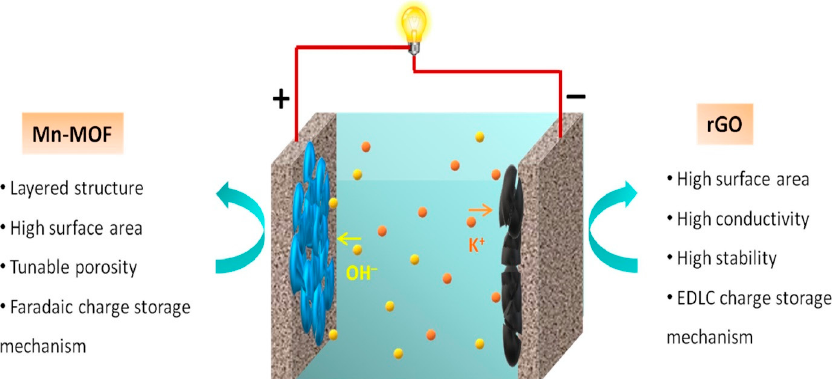
Figure 6. Schematic illustration of hybrid supercapacitor with Mn-MOF as a positive electrode and rGO as a negative electrode in KOH aqueous electrolyte [32].